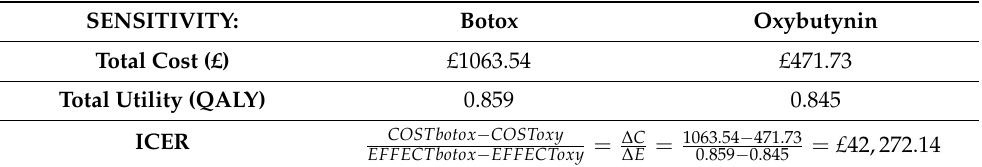
Table 4. Sensitivities of Botox and oxybutynin.